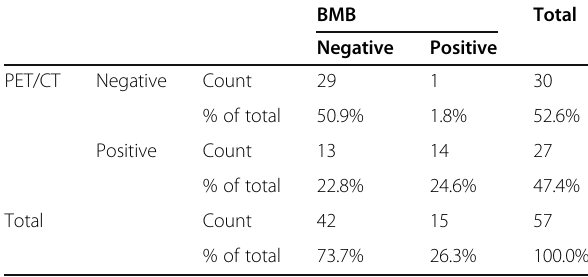
Table 12 Agreement between PET/CT and BMB in NHL cases